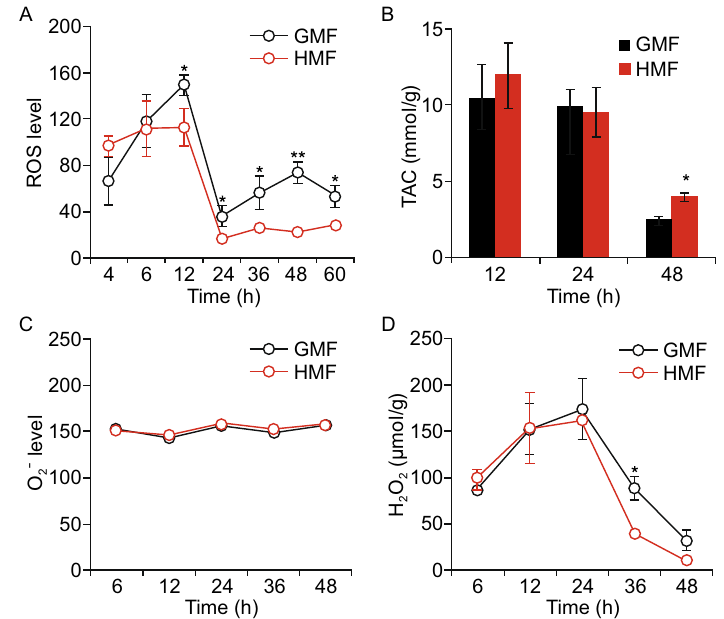
Figure 3. The dynamic changes of cellular ROS, TAC, H 2 O 2 , and O 2. − . (A) The ROS level in HMF-exposed cells was lower than the control since 12 h. (B) The TAC level in HMF-exposed cells was higher than the control at 48 h. (C) O 2. − levels in the two groups kept the same level during the exposure. (D) The H 2 O 2 level in HMF-exposed cells was lower than the control at 36 h. Data were from independent experiments ( n = 3) and shown as mean ± s.e.m. The P values were calculated using one-way ANOVA. * P < 0.05, ** P <